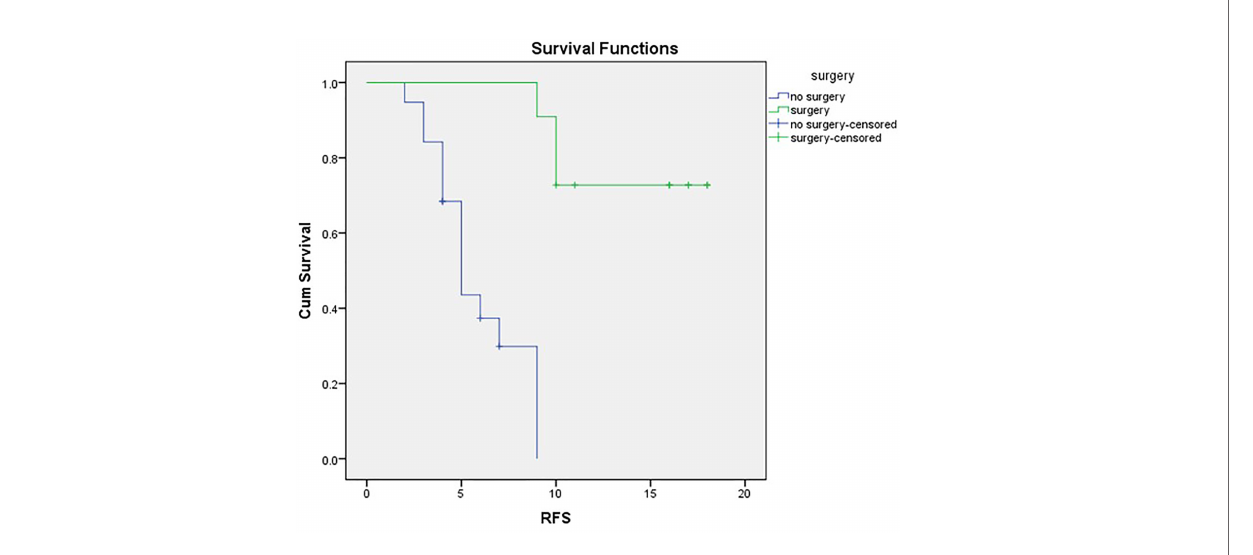
FIGURE 2 | RFS in surgical and non-surgical